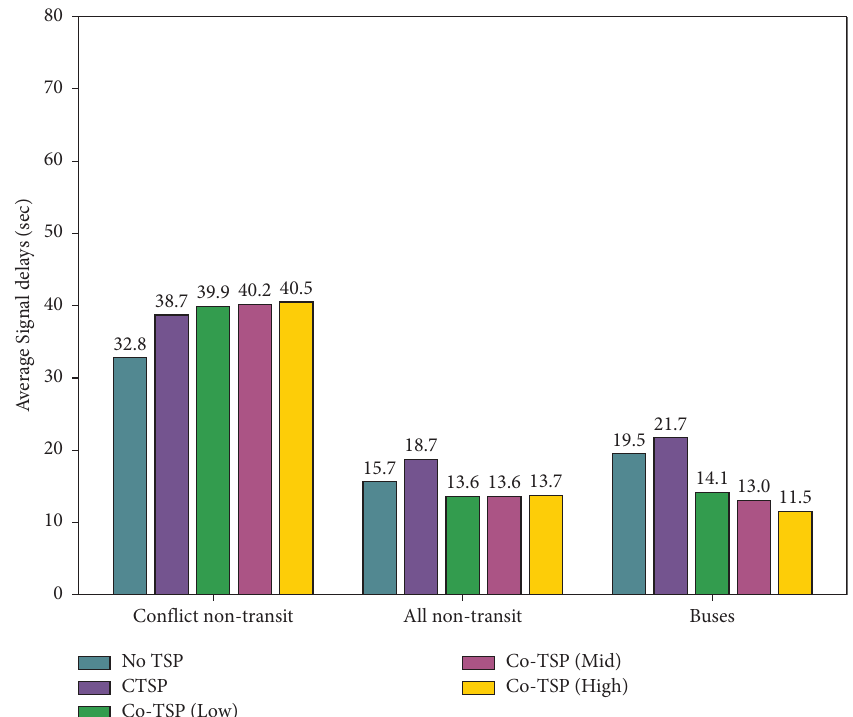
Figure 9: Performance of Co-TSP. Note: “confict nontransit” stands for the nontransit vehicles in confict directions; “all nontransit” represents all the nontransit vehicles in the intersection. “Buses” are buses that have been given